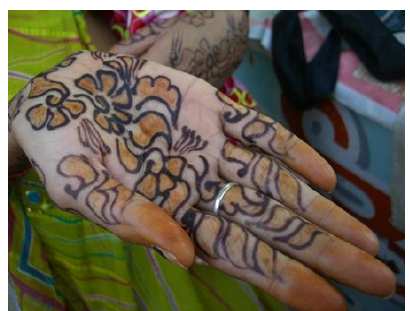
Figure 1. Painted hand, Madhya